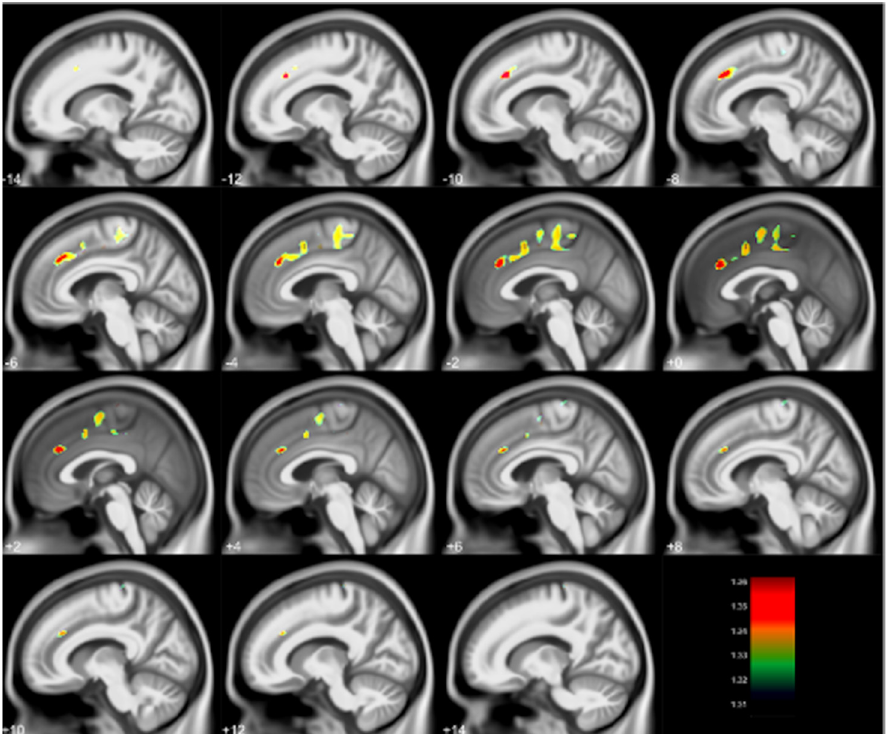
Figure 2. Regional gray matter volume loss inversely associated with childhood blood lead concentrations obtained at age 78 months with covariates from the Cincinnati Lead Study. The population imaged includes 123 adults ages 27–33 years imaged at 3 Tesla. Clusters were corrected for multiple comparisons (FWE = 0.05) using threshold free cluster enhancement. Negative slice numbers = left hemisphere, positive slice numbers = right hemisphere. Color bar represents − log( p ) value from 1.31 to 1.36.